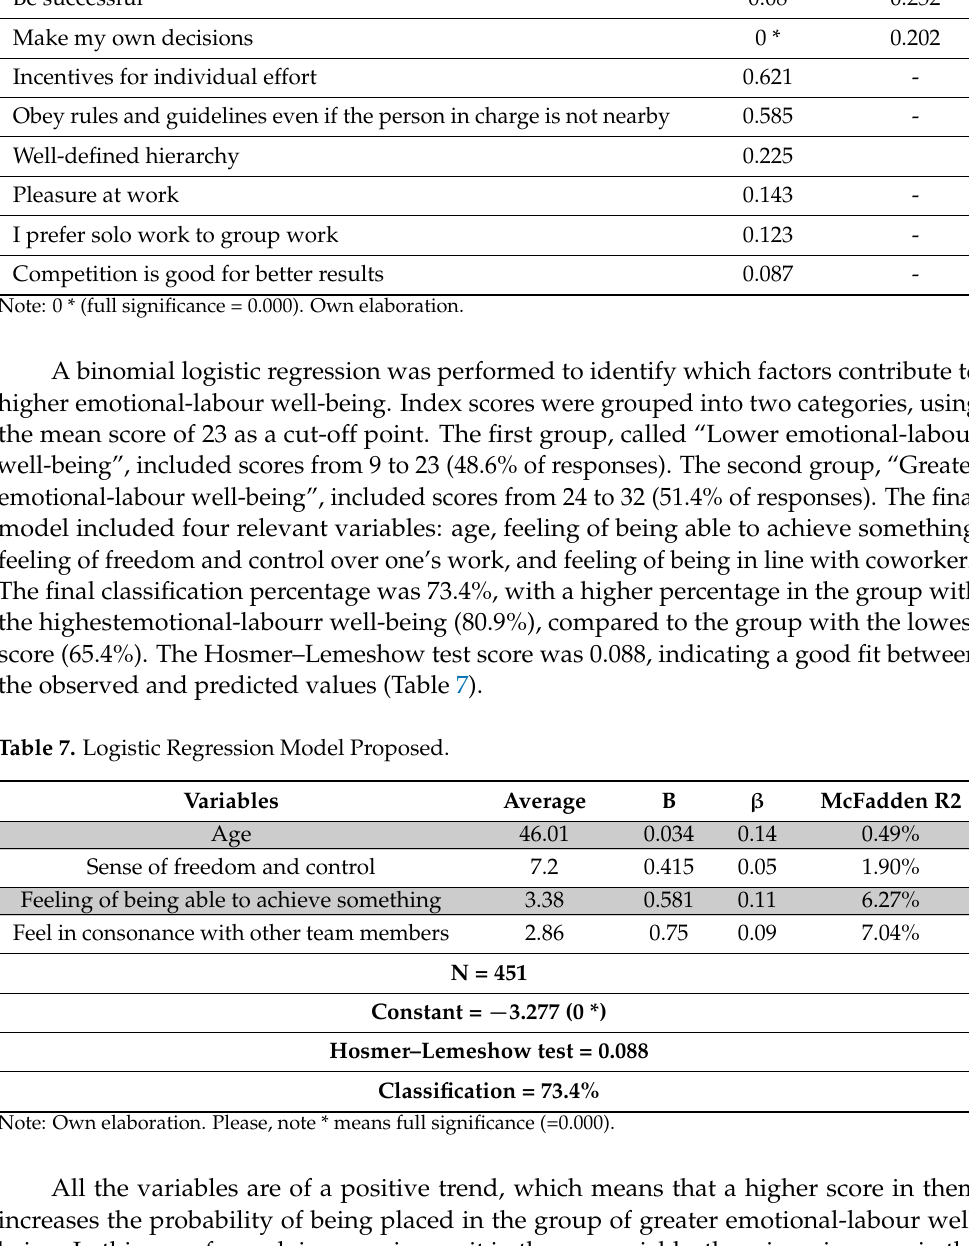
Table 6. Cross Tabulation. Attitudes towards work and its organization and SEWBI. Item